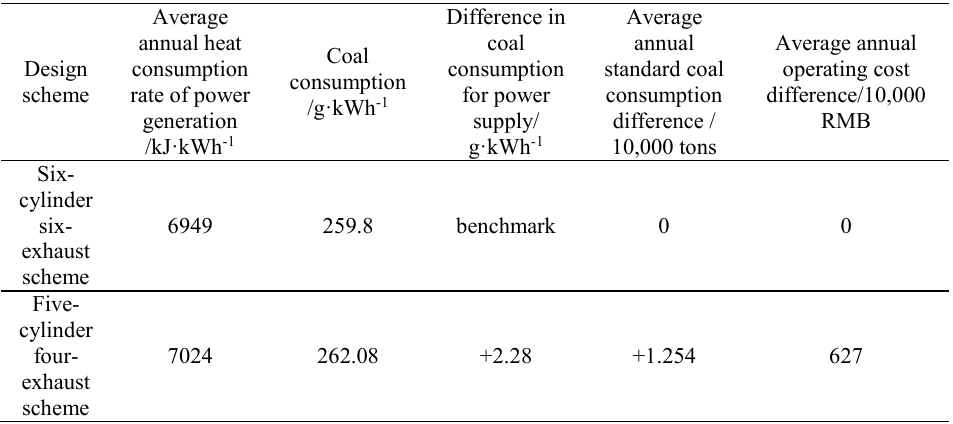
Table 5. Comparison of heat consumption rate, coal consumption and operating cost of a single unit in the two schemes.